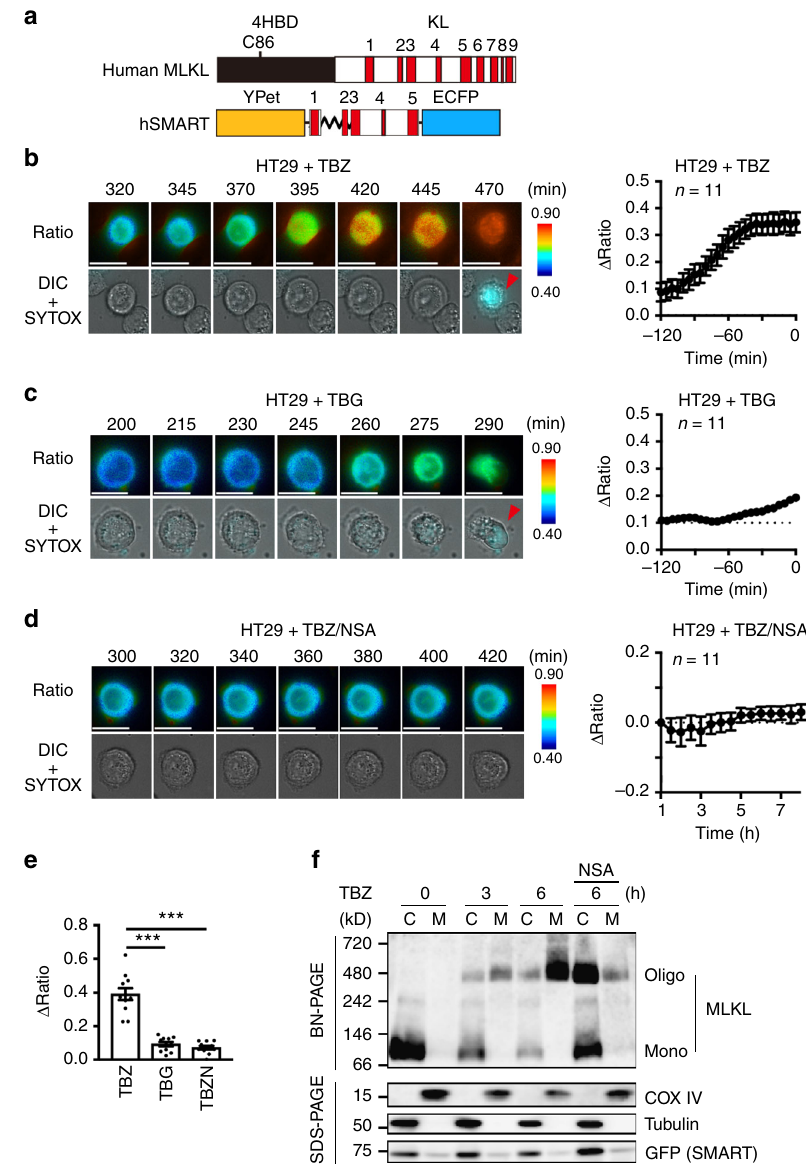
Fig. 6 hSMART monitors necroptosis in human cells. a Diagram of hSMART. b – e HT29 cells stably expressing hSMART were stimulated with TBZ ( b ), TBG ( c ), or TBZ + NSA ( d ). The FRET/CFP ratio was analyzed as in Fig. 1b. Representative images of the ratio of a single cell (left) and kinetics of average of Δ FRET/CFP ratio of cells (right) ( n = 11 cells). Ratio and DIC + SYTOX indicate the FRET/CFP ratio, and merged images of DIC and SYTOX Orange, respectively. Red arrowheads indicate SYTOX-positive cells. Time 0 indicates the time of cells that became SYTOX-positive ( b , c ). Otherwise indicated, time indicates the time after stimulation ( d ). Scale bars, 20 μ m. Color scales indicate pseudocolor images of the FRET/CFP ratio. Maximum changes of the FRET/CFP ratio ( e ). Each dot indicates individual cell ( n = 11 cells). Statistical signi fi cance was determined using the one-way ANOVA test. *** P < 0.001. Error bars indicate s.e.m. Pooled results of two independent experiments. f SMART monitors plasma membrane translocation of oligomerized MLKL. HT29-SMART cells were stimulated with TBZ in the absence or presence of NSA for the indicated times. Then cytosolic and membrane fractions were prepared and subjected to BN-PAGE (upper panel) or SDS-PAGE under reducing conditions (lower panel). Expression of each protein in cytosolic (C) or membrane (M) fractions was determined by immunoblotting with the indicated antibodies. Oligo and mono indicate oligomers and monomer of MLKL, respectively. Results are representative of two independent